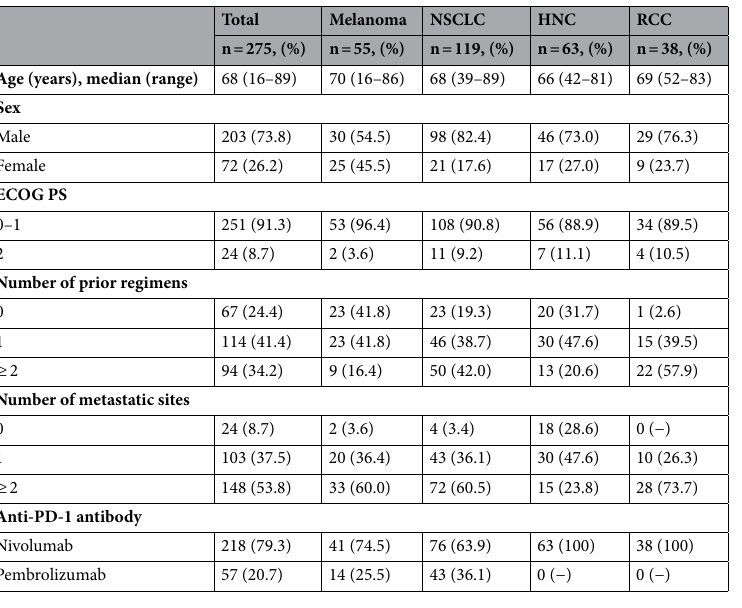
Table 1. Patient background. All patients are Asian. NSCLC non-small cell lung cancer, HNC head and neck cancer, RCC renal cell carcinoma, ECOG PS Eastern Cooperative Oncology Group performance status, PD-1 programmed cell